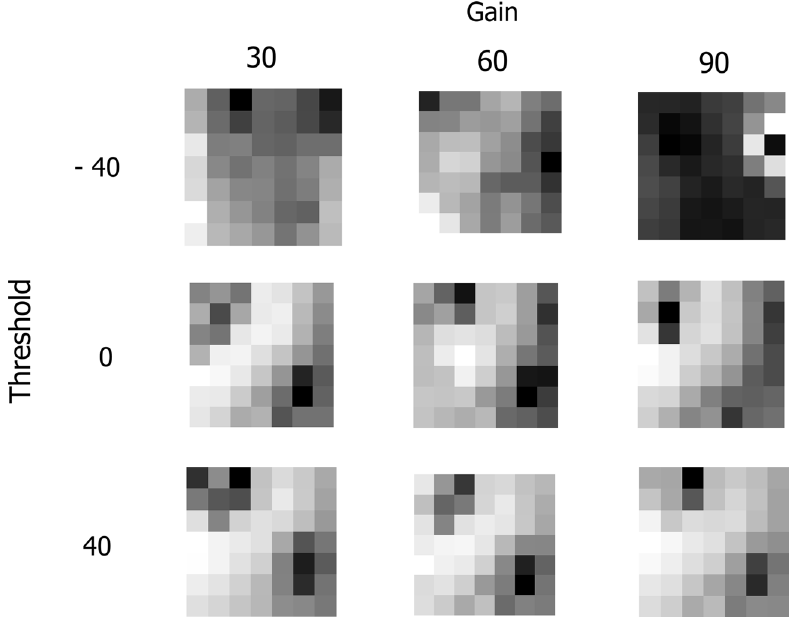
Figure 1: Nine di ff erent interpolation maps of the survey area, with data collected using variable settings on the detector. Speci fi c ground balance readings were omitted from this fi gure, because the result of this control sample is to identify similarities in interpolation results and not identical ground balance readings. Each square represents an area approximately 25 by 50